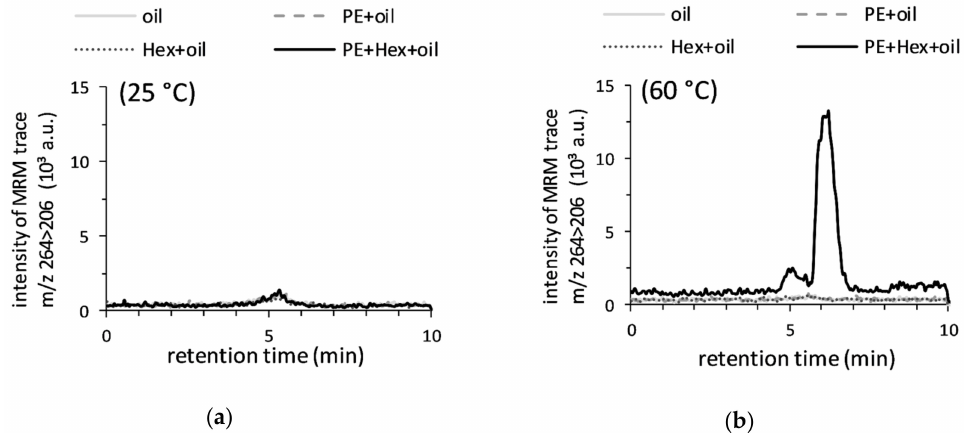
Figure 6. Formation of 2-pentyl-3,5-dibutyl-dihydropyridine in fortified cold-pressed soybean oils (CPSBO). A total of 50 µ l of the oil samples fortified with 4 mM PE (16:0 / 18:1) and / or 8 mM hexanal was dissolved in 1 mL chloroform-methanol (2:1) prior to LC-MS / MS analysis. The overlaid MRM chromatograms represent the formation of the dihydropyridine-derivative ( m / z 264 > 206) in oil after incubation with PE (16:0 / 18:1) and hexanal at 25 ◦ C ( a ) or at 60 ◦ C ( b ) for 60